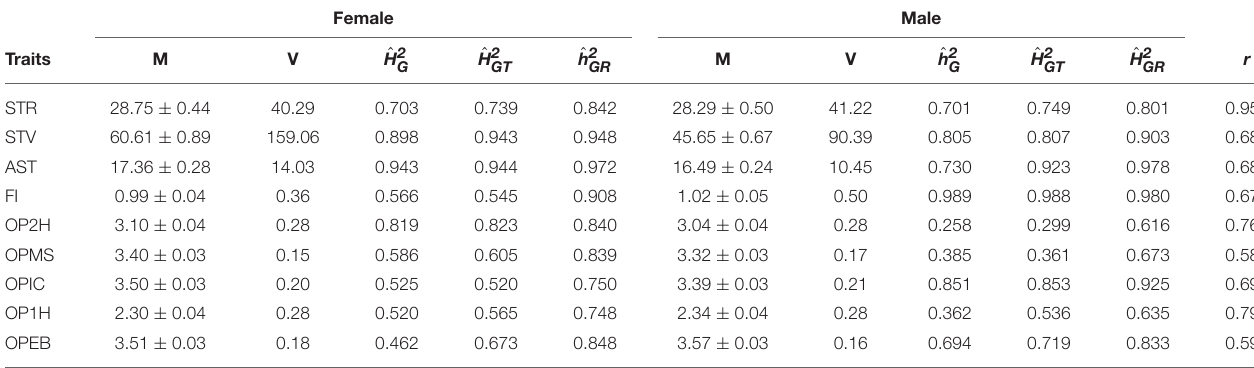
TABLE 1 | Line means (M) and variances (V) of phenotypes and heritability estimates for the nine traits in males and females.